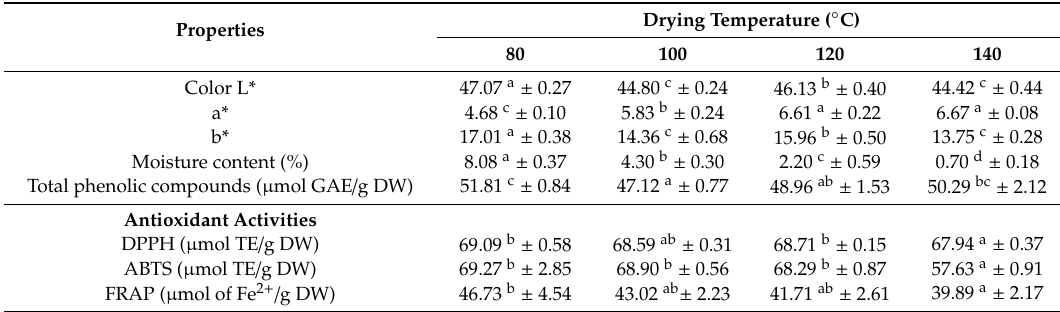
Table 3. Chemical properties and antioxidant activities of dried silkworms in a hot-air oven at di ff erent drying